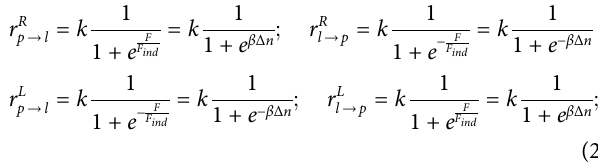
Frontiers in Applied Mathematics and Statistics |